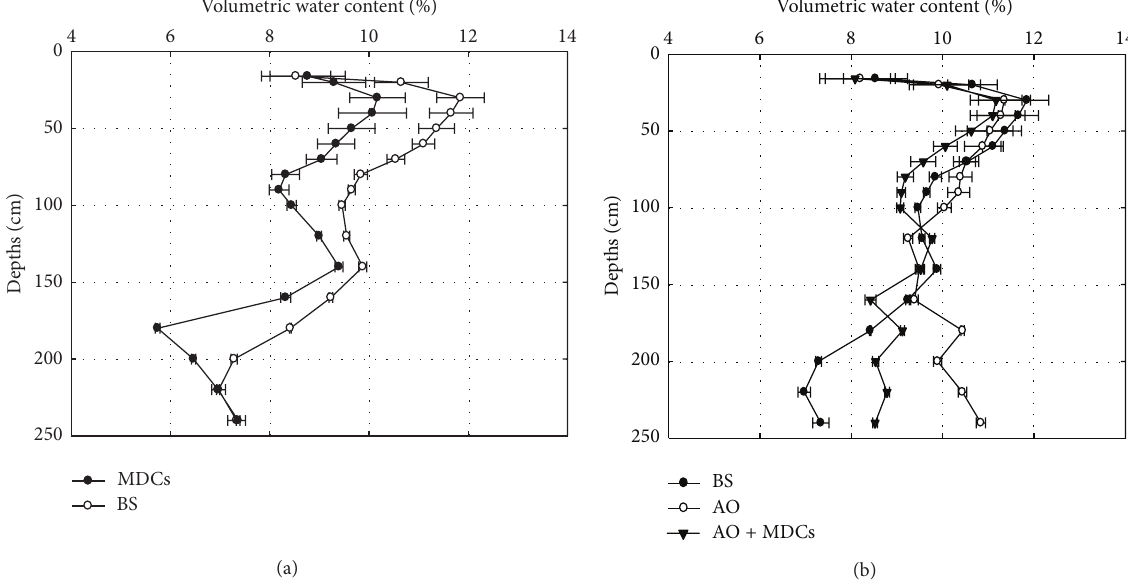
Figure 6: Volumetric water content from 10cm to 240 cm of bare sand plots (BS), moss-dominated crusts plots (MDCs), Artemisia ordosica plots (AO), and Artemisia ordosica combined with moss-dominated crusts plots (AO + MDCs) in the rainy season (July to September).